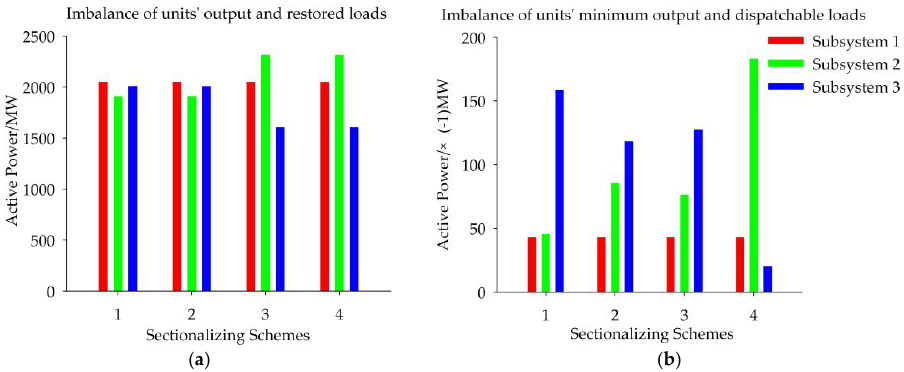
Figure 10. Comparison on: ( a ) IORL; and ( b ) IMODL of the candidate sectionalizing schemes.